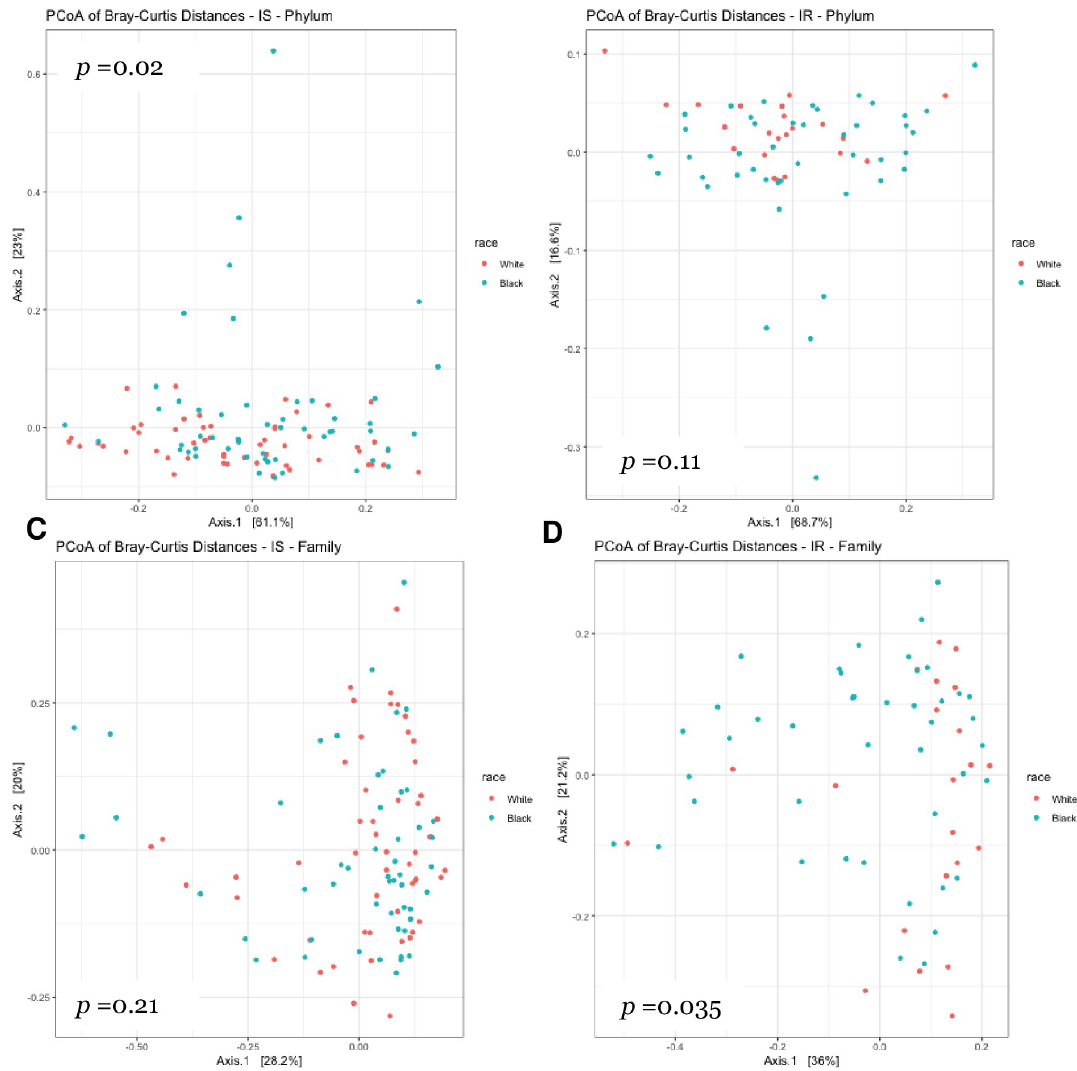
Fig 6. Race comparisons of beta diversity of bacteria by insulin sensitivity status. Principal coordinate analysis (PCoA) of relative abundance of taxa at the phylum level amongst A) insulin sensitive women ( n = 101) and B) insulin resistant individuals ( n = 64). Principal component of analysis (PCoA) of relative abundance of taxa at the family level amongst C) insulin sensitive women ( n = 101) and D) insulin resistant individuals ( n = 63). Relative abundance was measured by 16S rRNA gene PCR and sequencing.